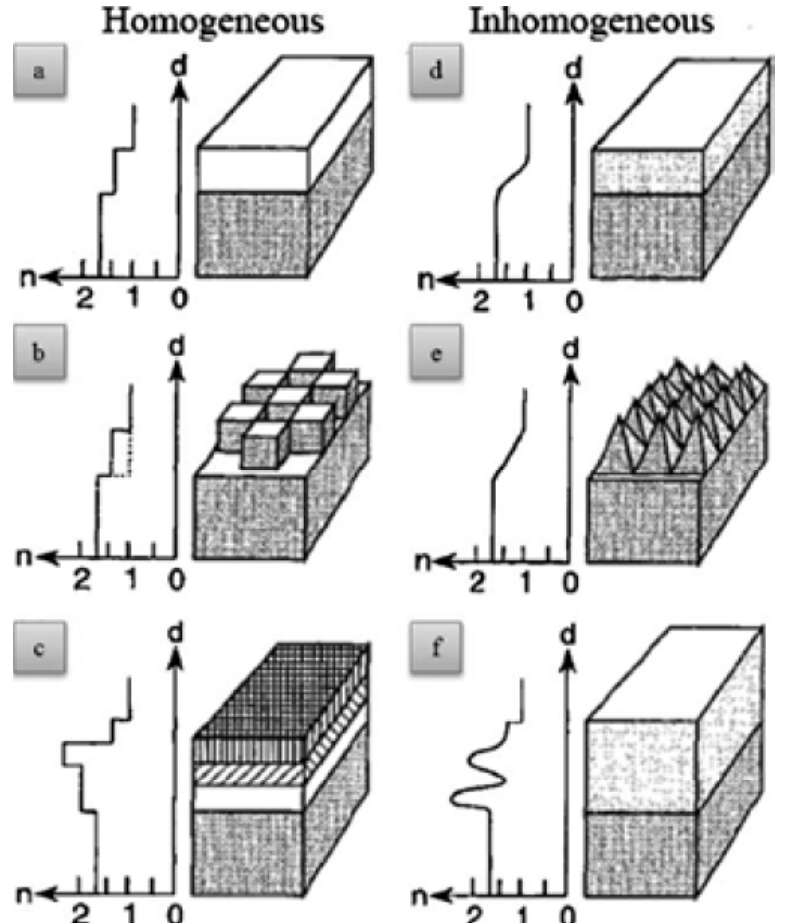
Fig. 3. Single layer Homogeneous ARCs, (a), patterned Single layer Homogeneous ARCs (b) multilayer Homogeneous ARCs (c) single inhomogeneous layer ARC (d), patterned single layer inhomogeneous ARC (e) multi-layer inhomogeneous ARC (f). The variation in refractive index in regards to the thickness of the film. Reprinted with permission from J. Dobrowolski, D. Poitras, P. Ma, H. Vakil and M. Acree // Applied optics 41 (2002)